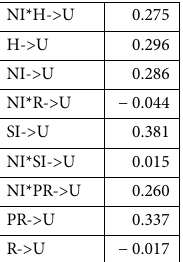
Table 5. Bootstrapping confidence interval up of HTMT. R perceived risk, SI social influence, PR perceived fairness, H habit, NI national identity, U